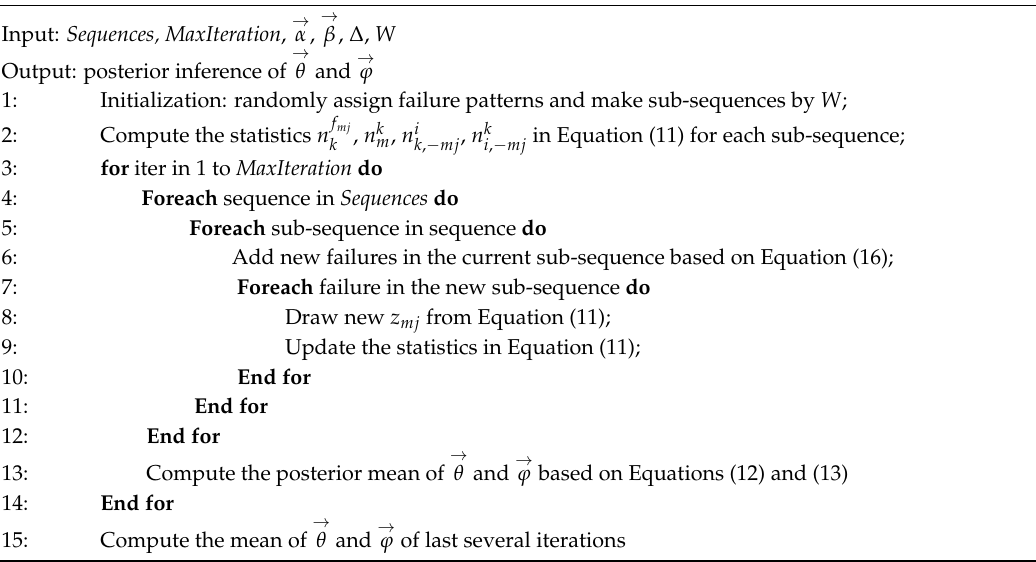
Figure 7. The sampling probability within and prior to the time window. Algorithm 1 Gibbs sampling with the new co-occurrence patterns